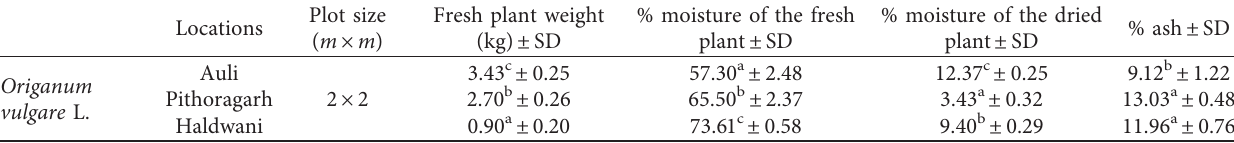
Table 2: Percent (%) moisture and weight of the fresh and dried plant material.